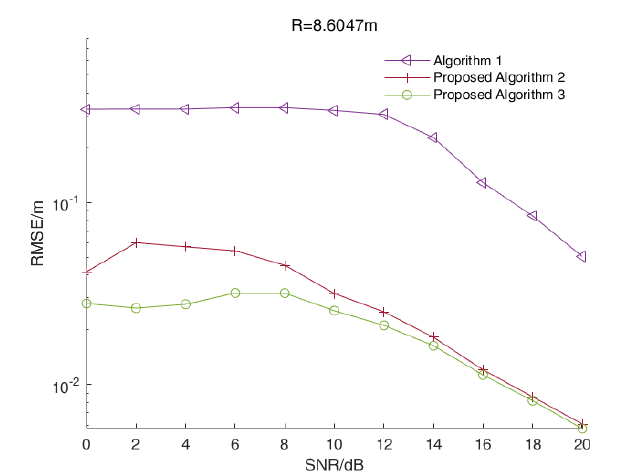
Figure 3. The RMSE values of the distance estimations versus the SNR values of all three algorithms when R = 8.4392 m.